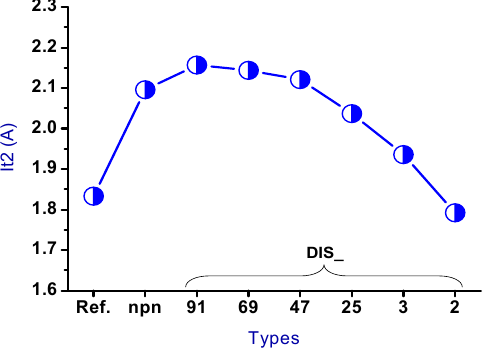
Figure 7. I t2 diagrams of the nLDMOS-SCR ( n-p-n -arranged) tested samples.